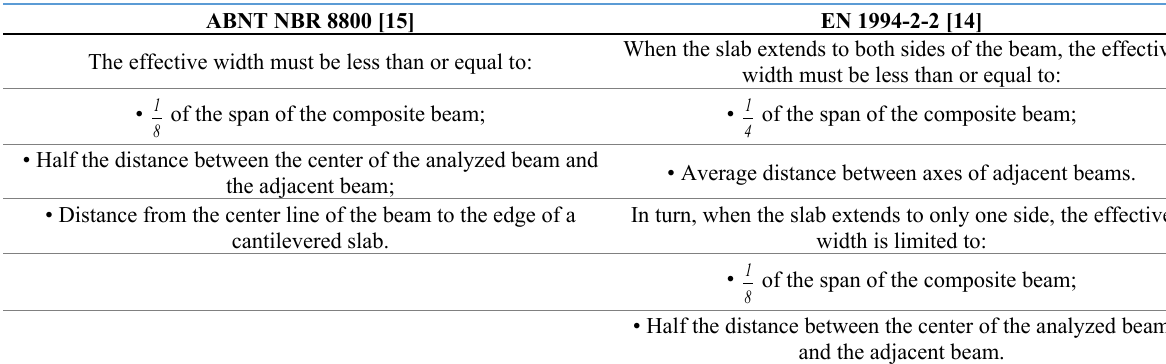
Table 1. Recommendations for calculating the effective width in simply supported beams in buildings. ABNT NBR 8800